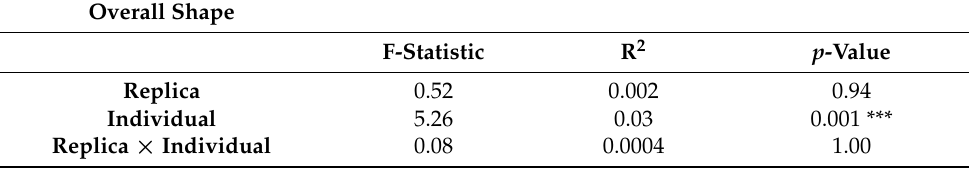
Table 2. Results of the Multivariate Procrustes ANOVA between the dependent variable of overall shape and the independent variables of “individual” and “replica” and their interaction. *** p -value ≤